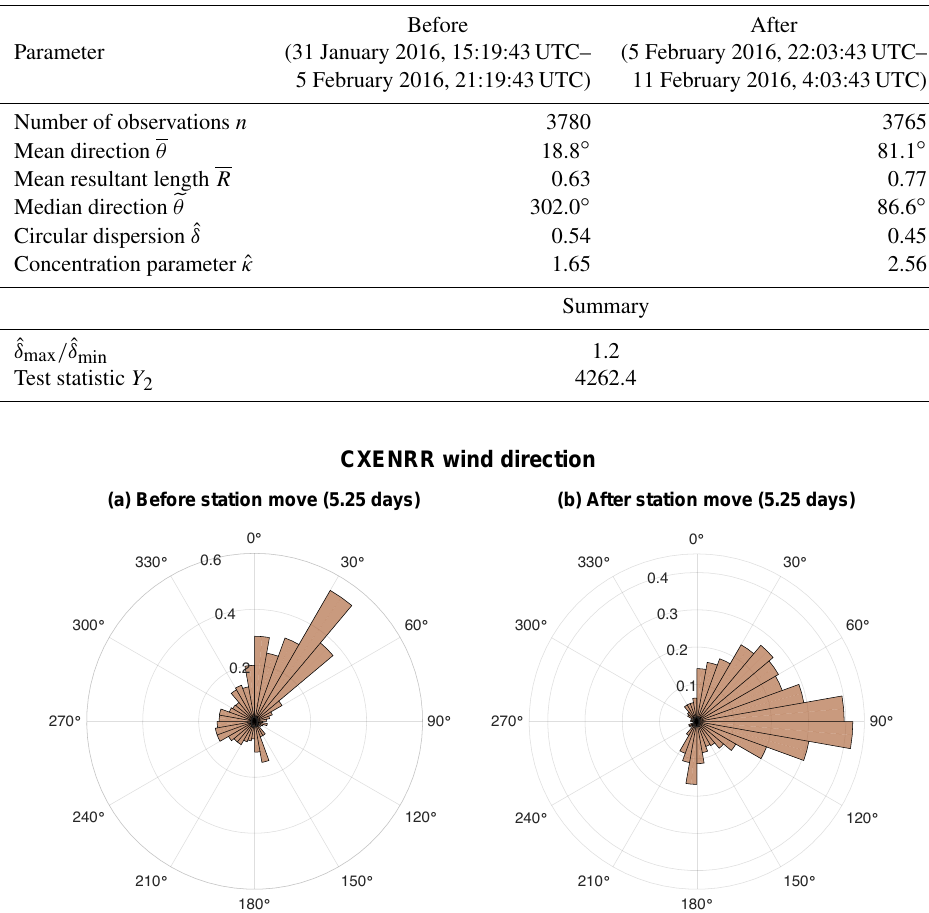
Table 4. Circular statistics computed from 5.25 days’ worth of 2min average CXENRR winds collected immediately before (left) and after (right) the CXENRR station was moved on 5 February 2016. The 3 ◦ directional correction discussed in Sect. 3.1.3 was applied before statistics were calculated. Statistical definitions are given in Appendix A1.